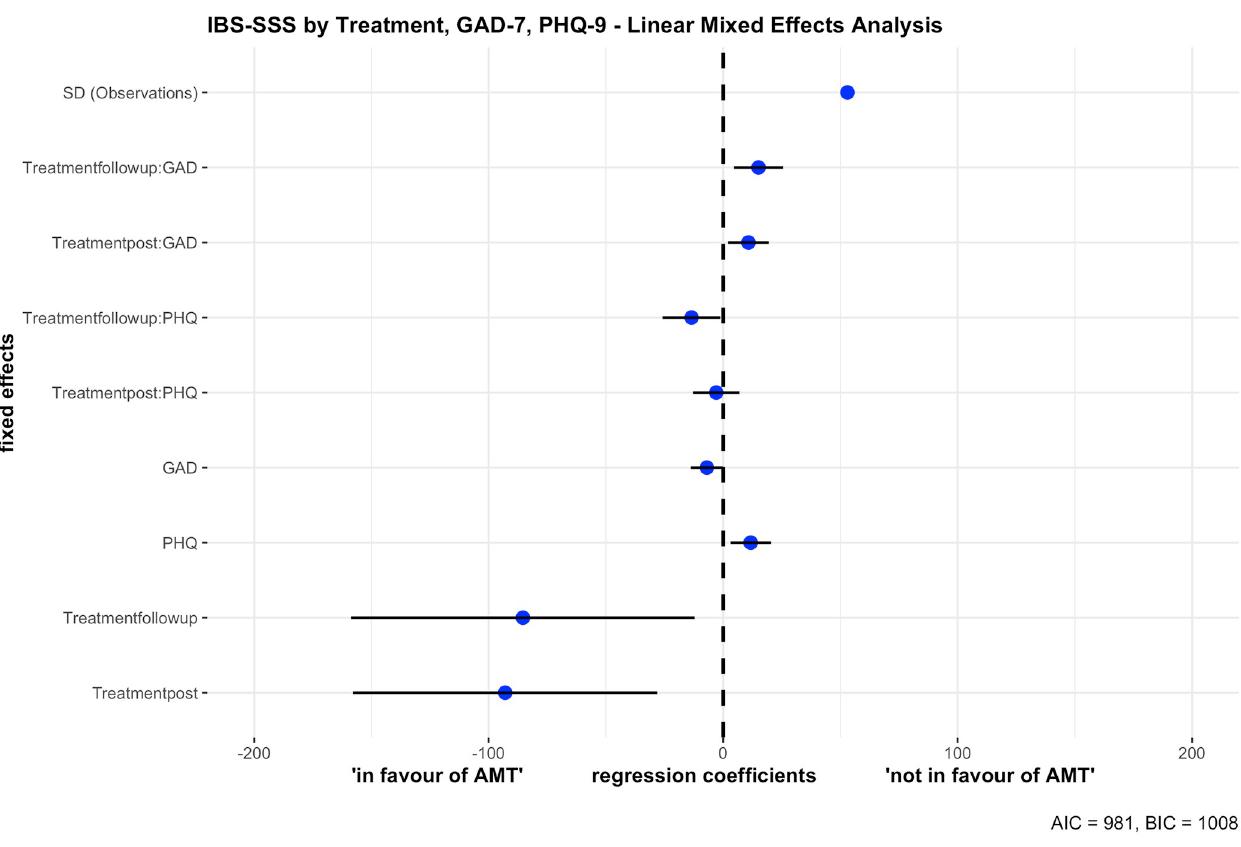
Fig 3. Forest plot showing the linear mixed effect analysis, predicting IBS severity by treatment, depressive and anxiety symptomatology and interaction effects between AMT at post and follow-up and mental comorbidity at both post and follow-up. Negative regression coefficients predict reduced IBS and positive coefficients predict increased IBS